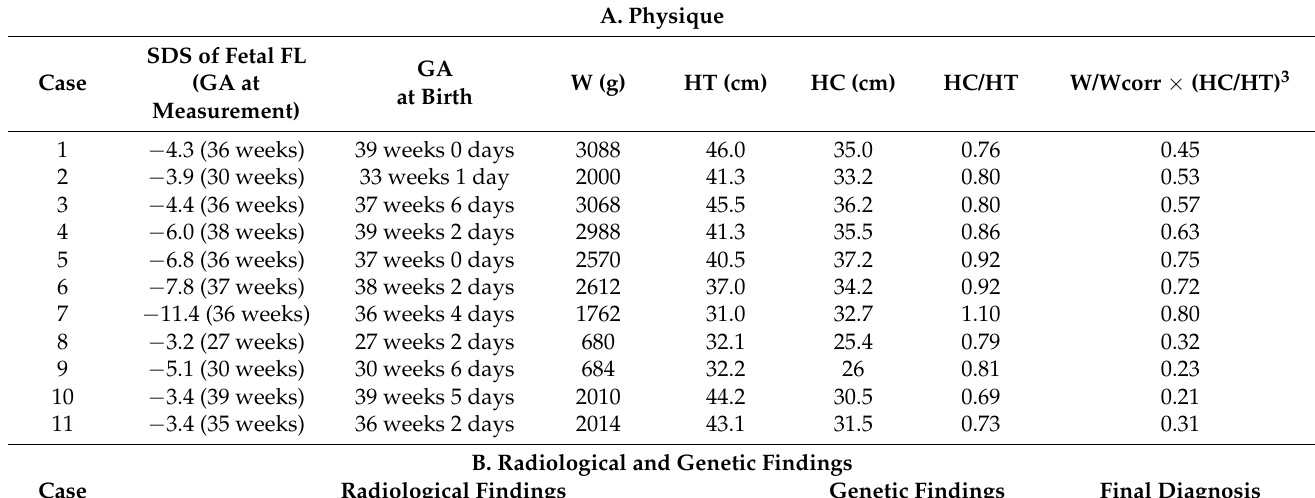
Table 1. Detailed data of 11 newborns with a fetal femoral length of < − 3.0 standard deviation score for the gestational